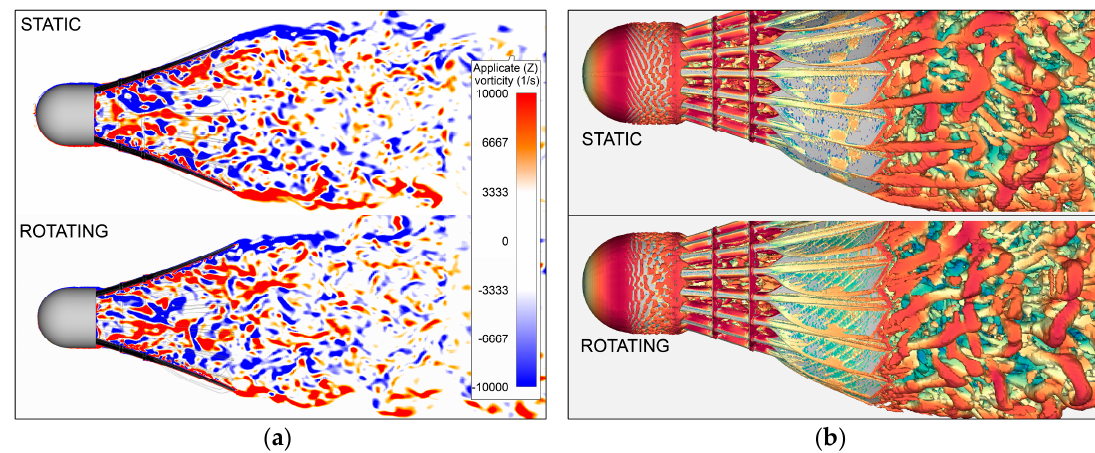
Figure 5. ( a ) Planar visualization of instantaneous vorticity in the applicate ( z ) direction, Re = 2.7 × 10 5 ; ( b ) visualization of vortical structures using the Q-criterion [10] method, Re = 2.7 × 10 5 .